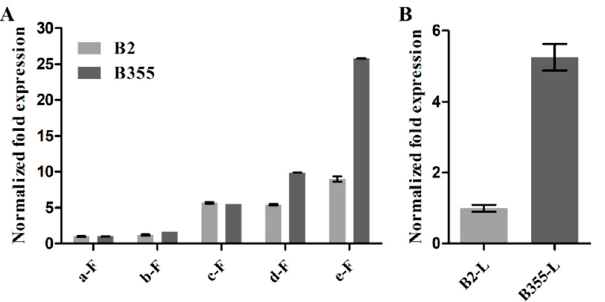
Figure 2. Relative expression levels of EjNACL47 . ( A ) Expression pattern of EjNACL47 in flower buds (a–e) of B2 and B355 loquat at different developmental stages. ( B ) Expression levels of EjNACL47 in leaves of B2 and B355 loquat. F: flower buds; L: leaf. Error bars represent the standard deviation of three independent